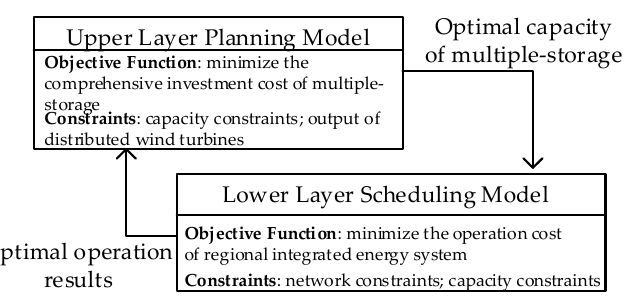
Figure 2. The framework of the bi-level optimization model.